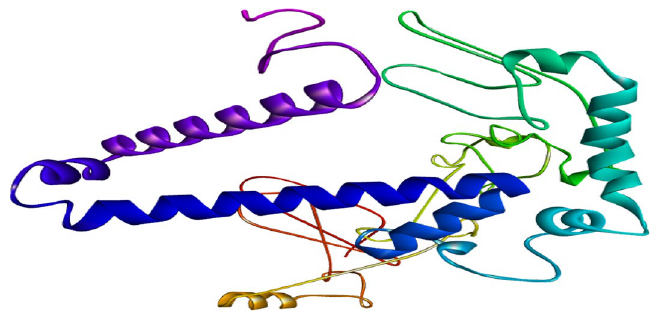
Figure 6. 3D vaccine structure using SWISS-MODEL 15